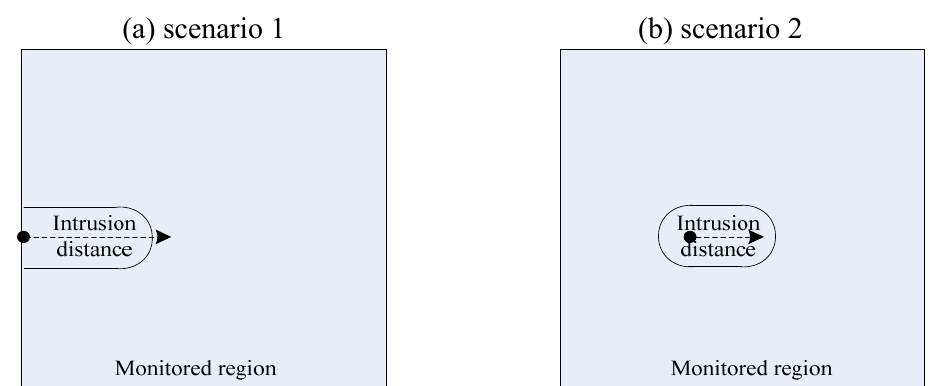
Figure 6. Intrusion scenarios. (a) The intrusion from the boundary of the monitored region. (b) The intrusion from inside the monitored